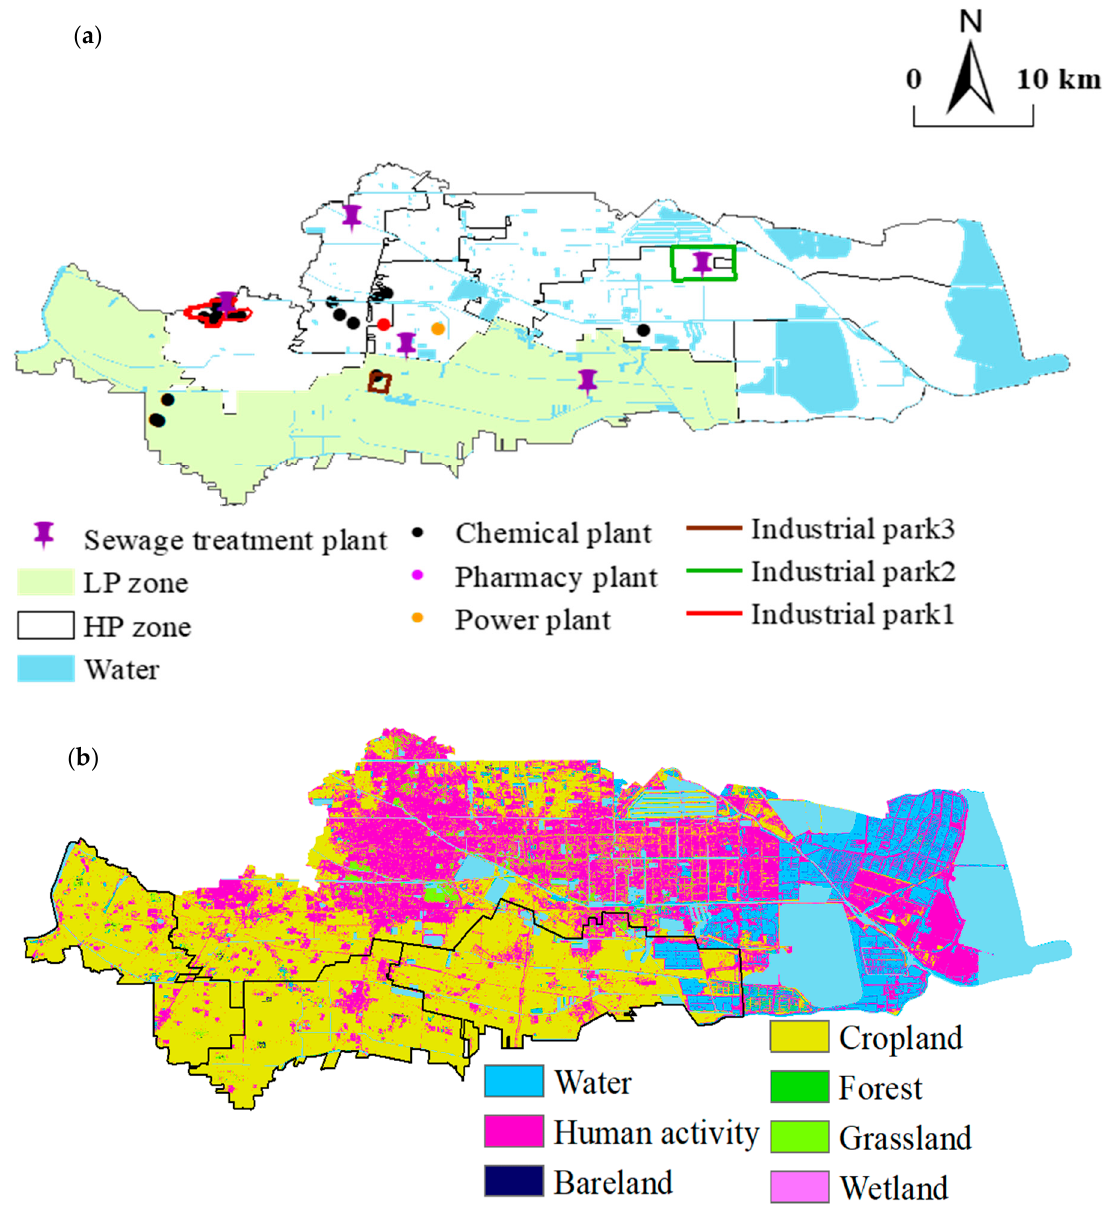
Figure 2. Maps of industry and sewage treatment plants ( a ), and land use types ( b ) in Dongying District.